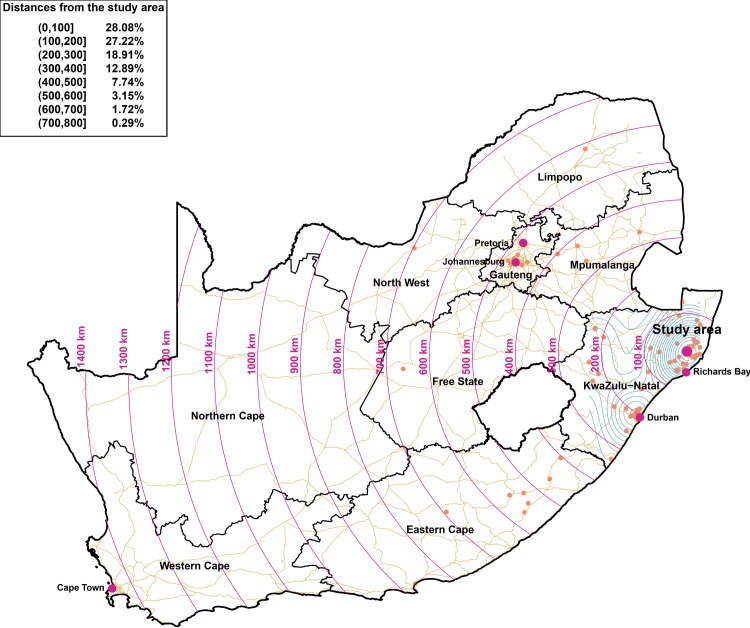
Map of the spatial distribution of the migration locations in South Africa (orange dots).The location of the Africa Health Research Institute rural study community is represented by a larger violet dot, whereas cities that are key migration destinations are represented by smaller violet dots. We mapped the motorways, trunk, and primary roads in South Africa, together with the boundaries of the nine South African provinces.